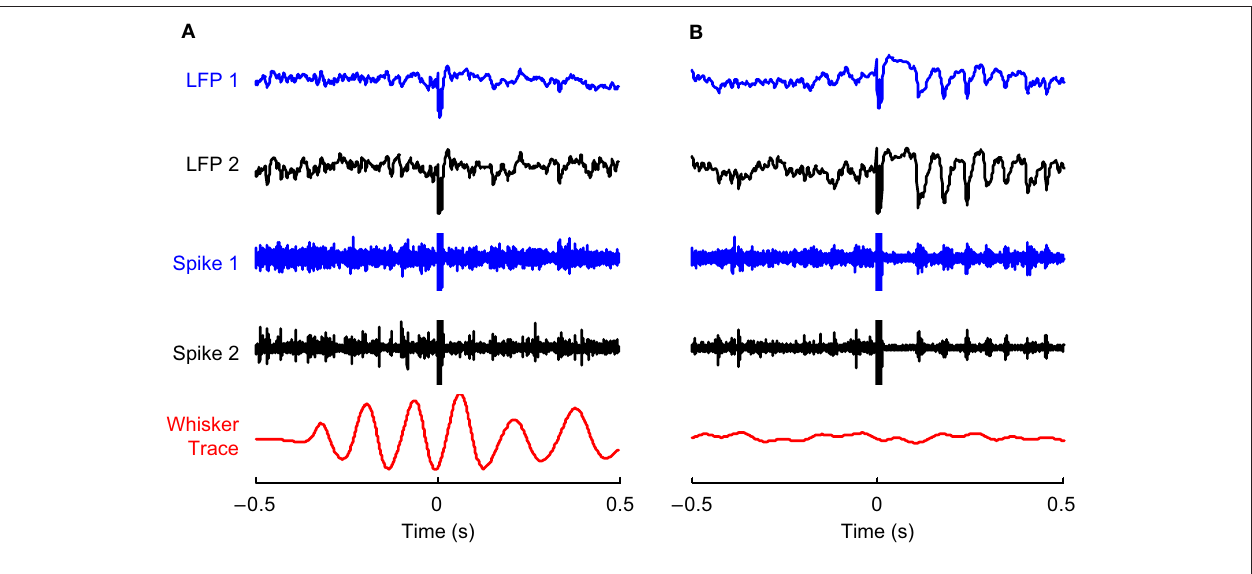
FIGURE 1 | Evoked responses to cortical microstimulation. (A) 1–200 Hz local fi eld potential (LFP) and 0.5–10 kHz multiunit activity (Spike) recorded from two electrodes in infragranular layer of barrel cortex of awake rats are shown along with traces of whisker movements. Microstimulation (at 0 s) delivered during active whisking typically induced a small neural response which is